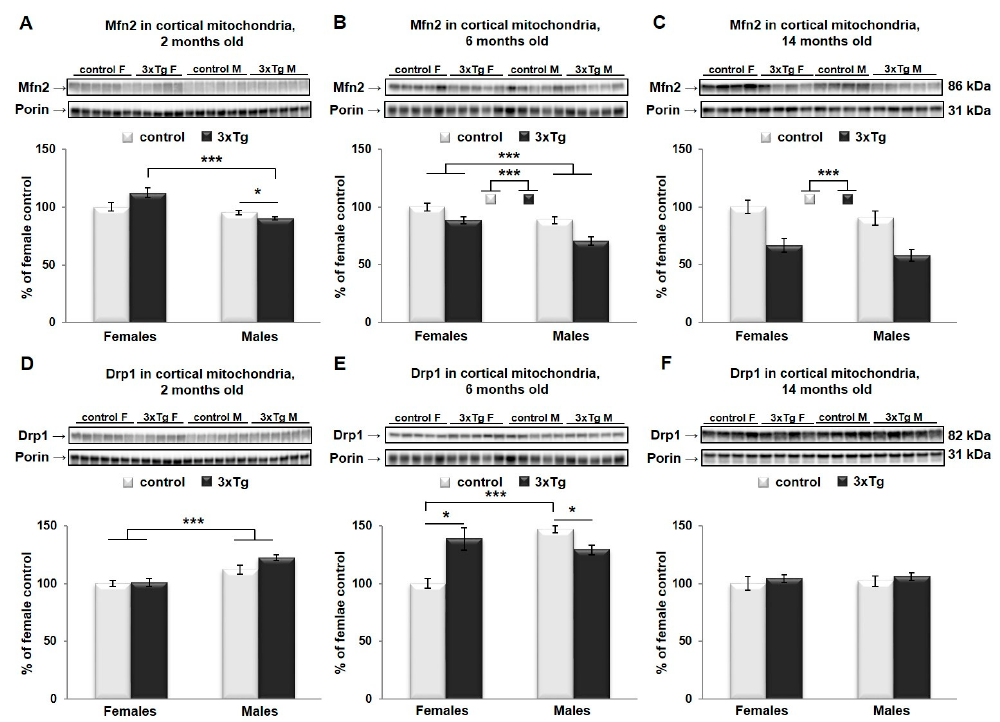
Figure 4. Mfn2 and Drp1 protein levels in cortical mitochondria. Representative WB for Mfn2 ( A – C ) and Drp1 ( D – F ) and their relative quantification normalized to porin protein levels in the cortex of 2-, 6- and 14-month-old 3xTg female and male mice and their respective controls. Data were analyzed by two-way ANOVA, and results are expressed as percent change from control mean of 100% ± SEM of n = 4–6 animals per group and Mfn2 protein levels were significantly different in cortical mitochondria as a function of sex (*** p < 0.001) in 2- and 6-month-old mice and genotype (*** p < 0.001) in 6- and 14-month-old mice, with a significant interaction effect between sex and genotype only in 2-month-old mice (** p < 0.01). Analysis of simple main effects showed significantly lower levels of Mfn2 in 3xTg males versus 3xTg females (*** p < 0.001) and downregulation in the 3xTg male mice compared to controls ( p = 0.03). Drp1 protein levels were significantly different in cortical mitochondria as a function of sex in 2- and 6-month-old mice (*** p < 0.001 and ** p < 0.01 respectively), with a significant interaction effect between sex and genotype only in 6-month-old mice (*** p < 0.001). Here, levels of Drp1 were significantly higher in males than females in the C57BL/6 mouse (*** p < 0.001) and in the 3xTg female relative to their background control females (* p < 0.05). Drp1 was significantly reduced in 3xTg males relative to male control mice (* p < 0.05). In the hippocampal mitochondria, two-way ANOVA analysis revealed that Mfn2 protein levels were significantly different as a function of genotype in 6- and 14-month-old mice (Mfn2 protein levels were lower in 3xTg animals, ** p < 0.01 and *** p < 0.001 respectively, Figure 5B and 5C), and as a function of sex in 14-month-old mice (Mfn2 protein levels were higher in females, * p < 0.05, Figure 5C). No significant interaction effect between sex and genotype was detected for Mfn2 at any age group. At 2 months, there was a significant interaction effect for Drp1; analysis of simple main effects indicated an effect of sex in C57 mice only, with significantly higher levels in males than in females (*** p < 0.001). Drp1 protein levels differed significantly as a function of genotype in 6- and 14-month- old mice (** p < 0.01 and * p < 0.05 respectively), with a significant interaction effect (* p < 0.05) between sex and genotype in these two age groups as well. Drp1 levels were significantly higher as a function of genotype in females only in both age groups (6-month: p = 0.002; 14-month: p = 0.007). The effect